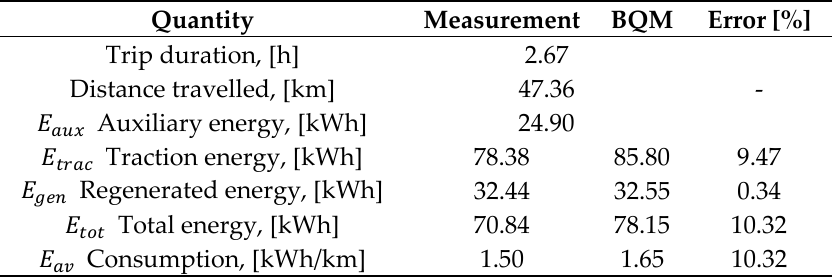
Table 1. Energy demand of the trolley bus.